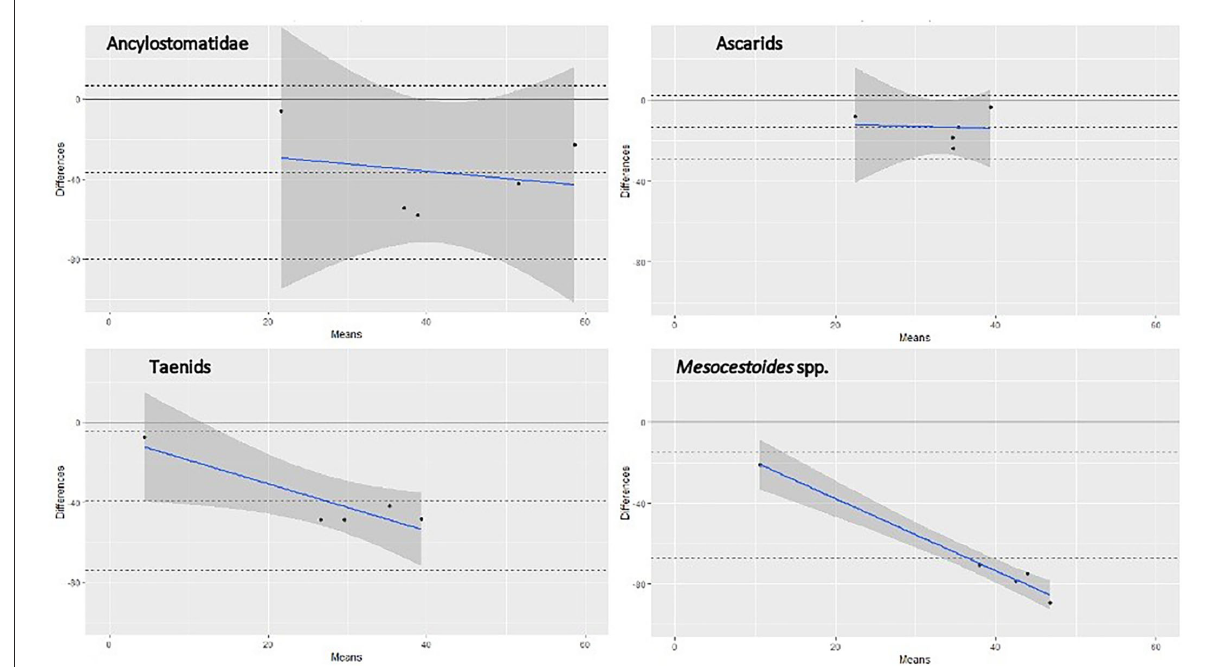
FIGURE1 Bland-Altman graph representing the agreement between SFCT (reference test) and copromicroscopy, for four different groups of helminths, based on literature data and those from the present study. Note: each dot represents one pair of prevalence values (scraping and copromicroscopic) reported in Table 4, identified by the mean of the two values in the x-axis and by the difference between the two values in the y-axis. The continuous gray line at the 0 value in the y-axis corresponds to the prevalence value at scraping (reference test), whereas the central dashed line is the mean difference of the copromicroscopic value. The continuous blue line shows the trend of the differences between values, at increasing mean prevalence values. Refer to the main text for references used in this